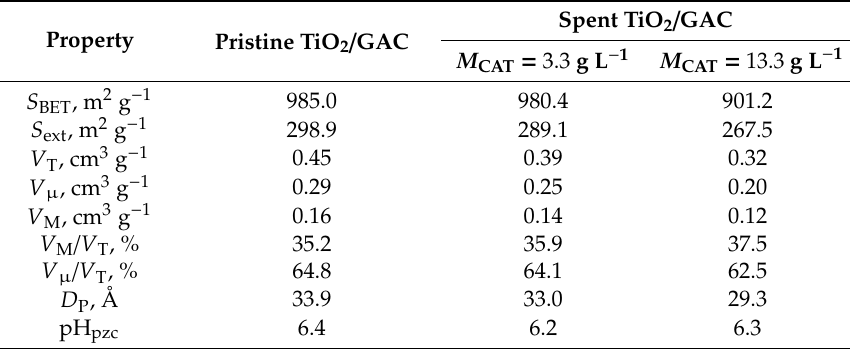
Table 4. Physicochemical properties of pristine and spent TiO 2 / GAC in aniline ozonation with di ff erent catalyst doses. Experimental conditions: Q G = 4 L min − 1 ; C O P = 1 atm; V reac = 1.5 L; ( Agitation ) = 60 rpm.